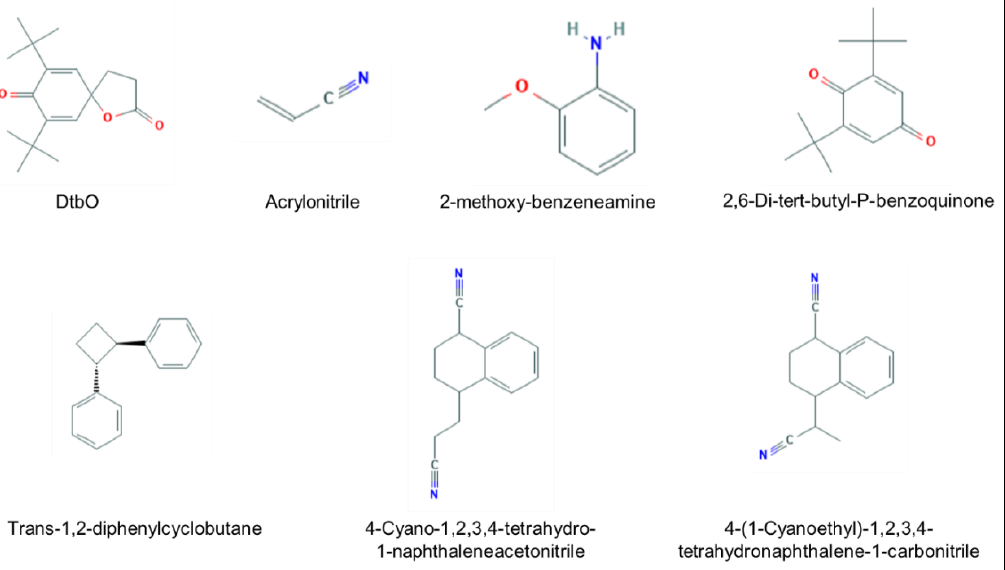
Figure 4. Structures of the detected compounds belonging to the Cramer class III.